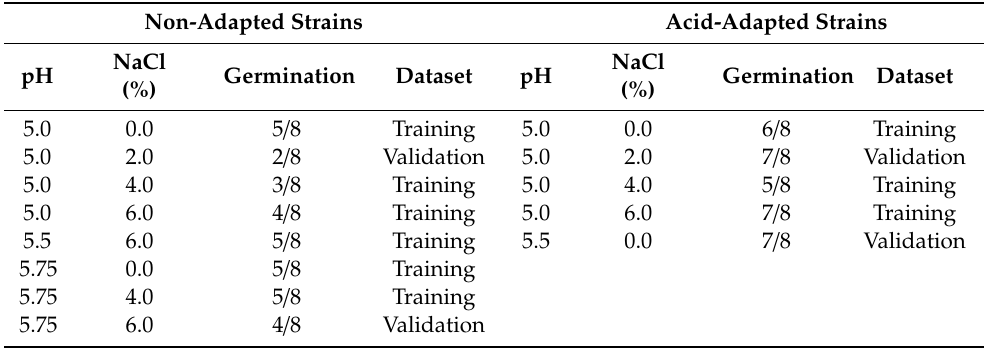
Table 5. Environmental conditions where a binary response was observed for C. sporogenes strains for the model and validation datasets after 42 d incubation at 30 ◦